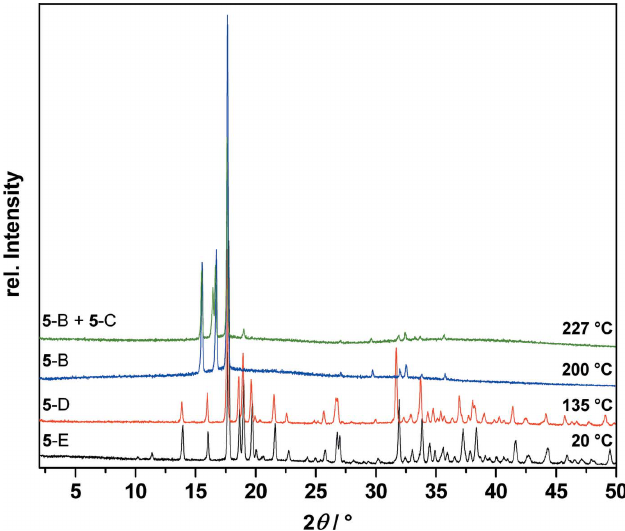
Figure 12 Temperature-dependent X-ray powder diffraction traces of cis -inositol ( 5 ) at 20, 135, 200 and up to 227 (cid:2) C showing the phase transitions of 5 -E (black) to polymorph 5 -D (red) to polymorph 5 -B (blue) and finally to a mixture of polymorphs 5 -B and 5 -C